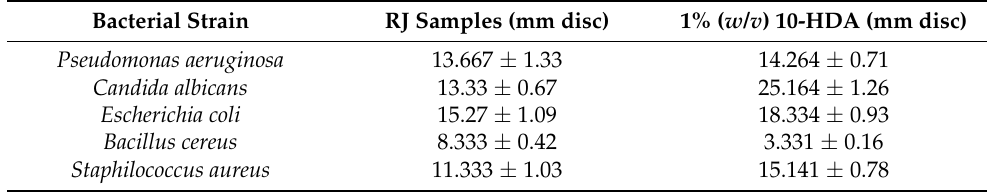
Table 3. Antimicrobial activity of RJ and